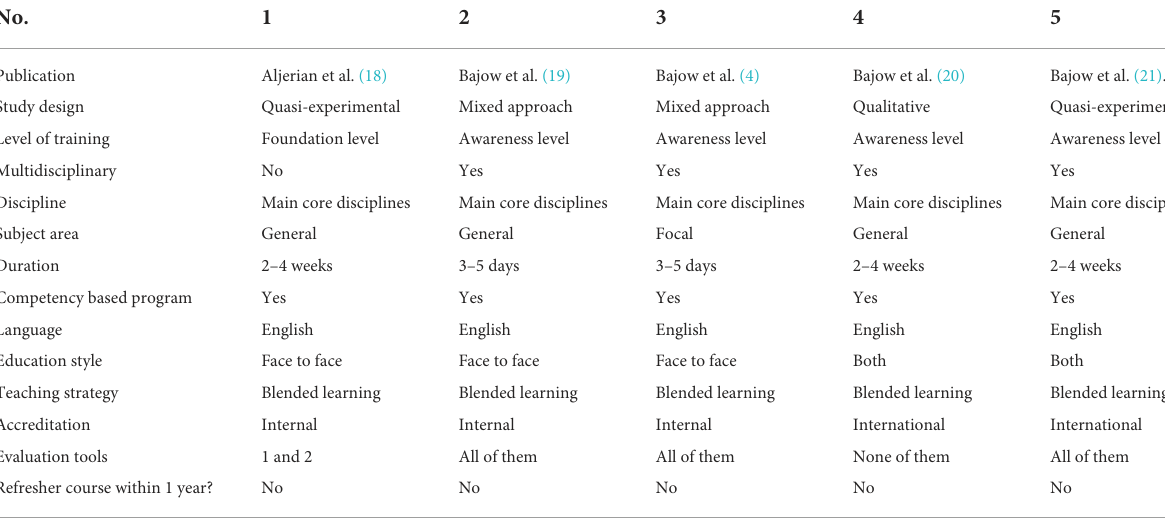
TABLE 3 Articles that met the eligibility criteria according to elements of the disaster health education framework.